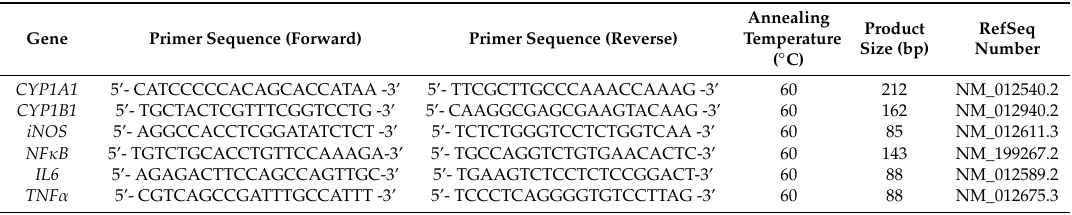
Table 1. Oligonucleotide primer sequences used for quantitative reverse transcription-polymerase chain